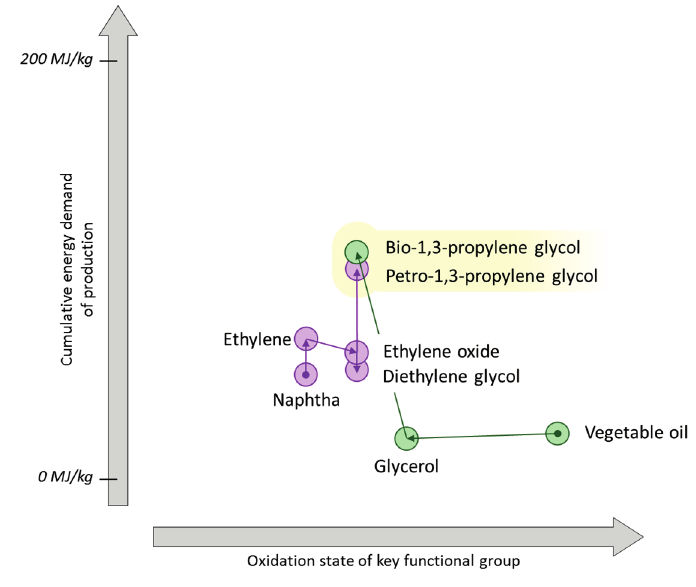
Figure 15. The cumulative energy demand of glycol solvent